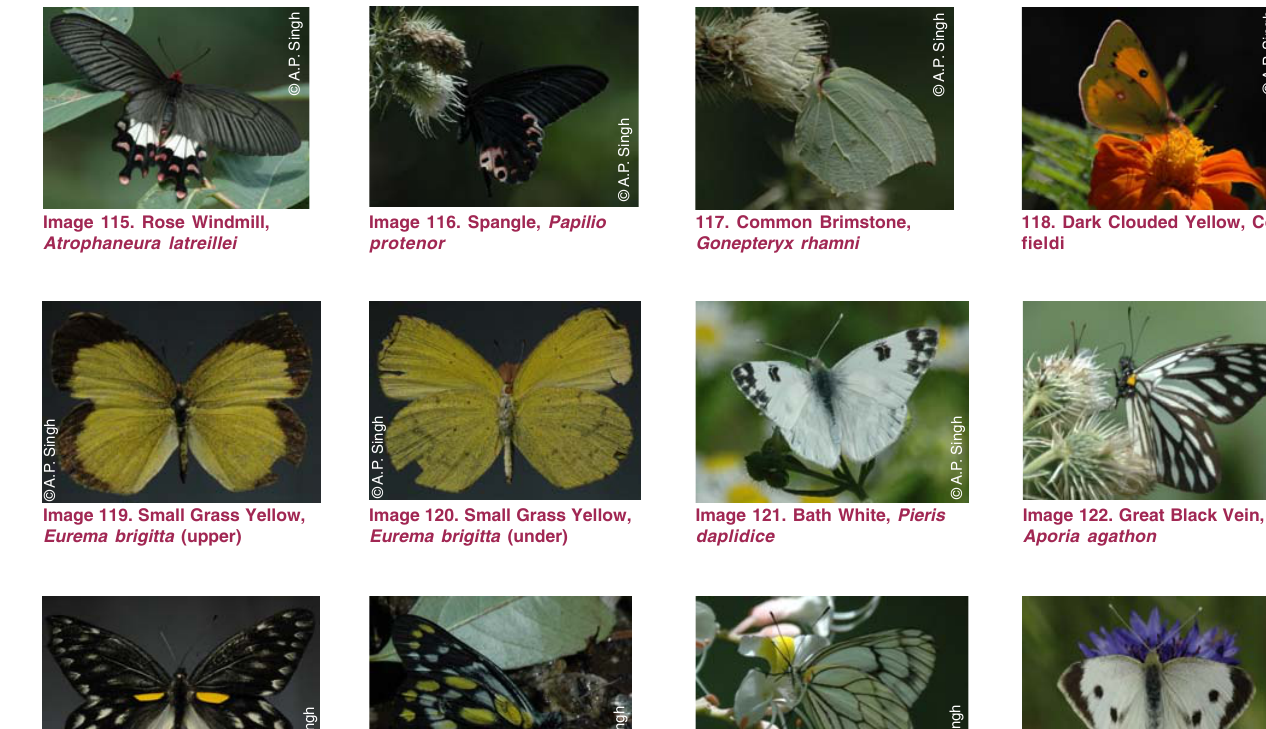
Image 124. Hill Jezebell, Delias belladonna